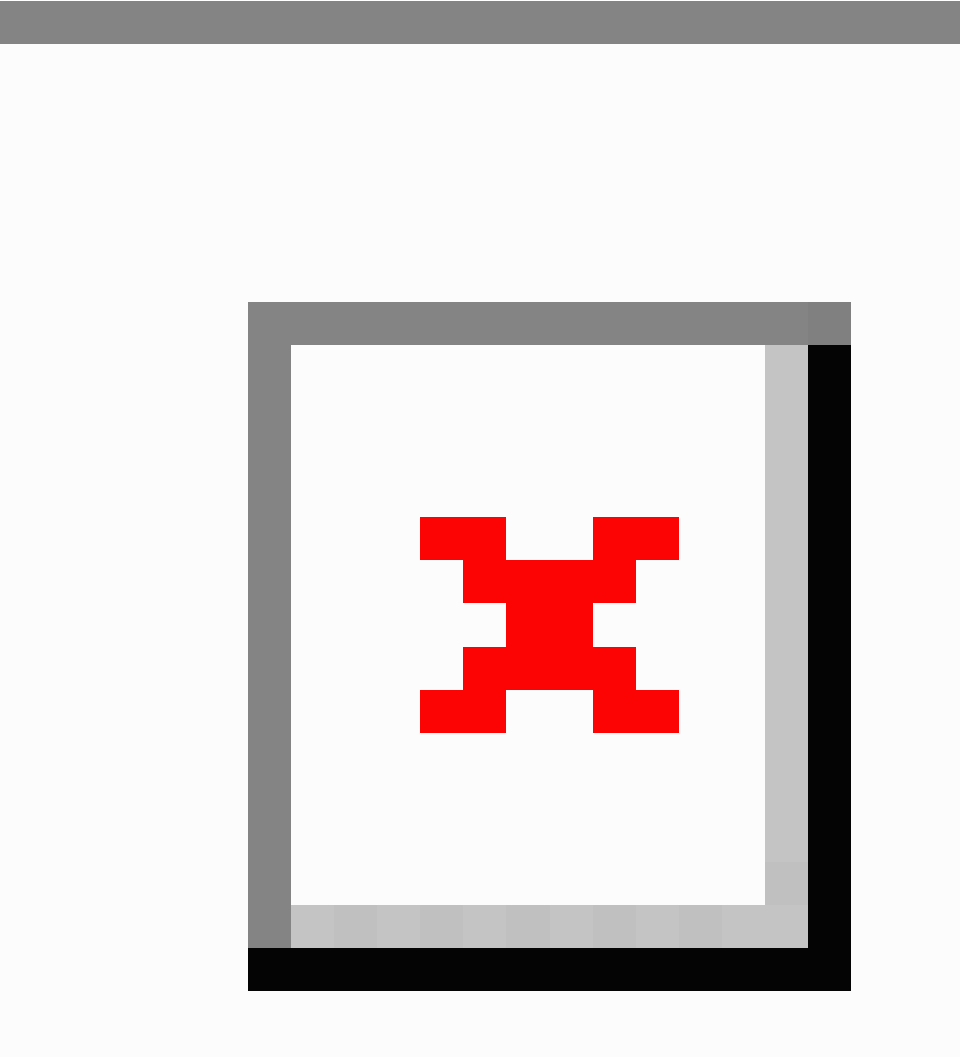
Figure 5. The user mobile health data (excerpt) queried from the state in the data update test when one of the validating peers (VPs) was down. (a) The successfully added user data after the Invoke step when VP1 was down (newly added data were highlighted). (b) The user data after the Invoke step when VP1 was rebooted (newly added data were